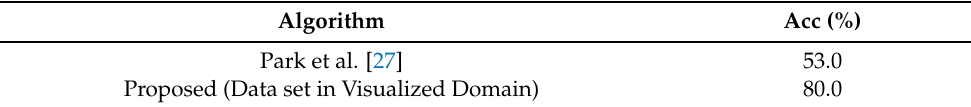
Table 5. Comparison of domain-based experimental results for acquired data